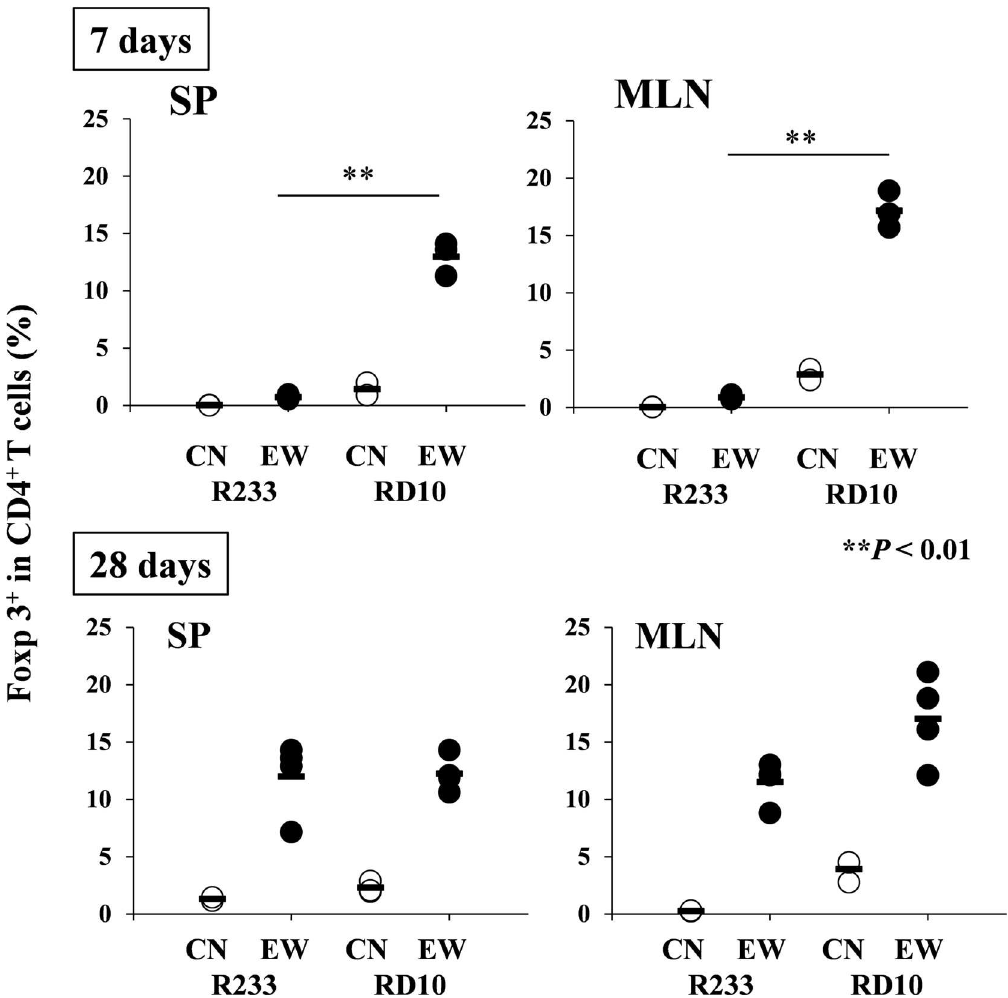
Fig 5. Induction of OVA-specific Foxp3 + CD4 + T cells in EW-fed R23-3 and RD10mice. The percentage of OVA-specific Foxp3 + CD4 + T cells per OVA-specific CD4 + T cells in R23-3 and RD10 mice duringcontinuousEW feedingis indicated.SP: spleen;MLN: mesenteric lymph node; RD10: RAG-2-deficient D10 mice; R23-3: RAG- 2-deficient OVA23-3 mice; CN: control diet group; EW: egg-whitediet group. These data are representative of two independent experiments. For day 7, R23-3 CN: n = 2; EW: n = 3; RD10CN: n = 2; EW: n = 3. For day 28, R23-3 CN: n = 2; EW: n = 4; RD10 CN: n = 3; EW: n = 4. ** , p <